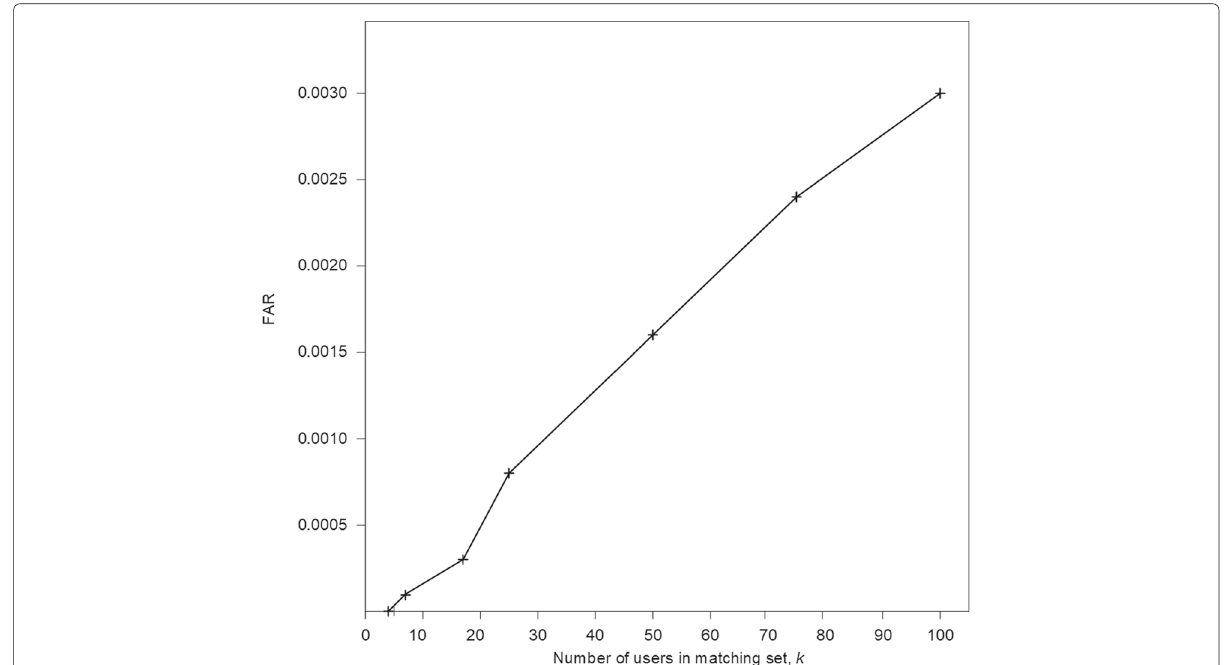
Fig. 8 FAR as a function of the size of the matching